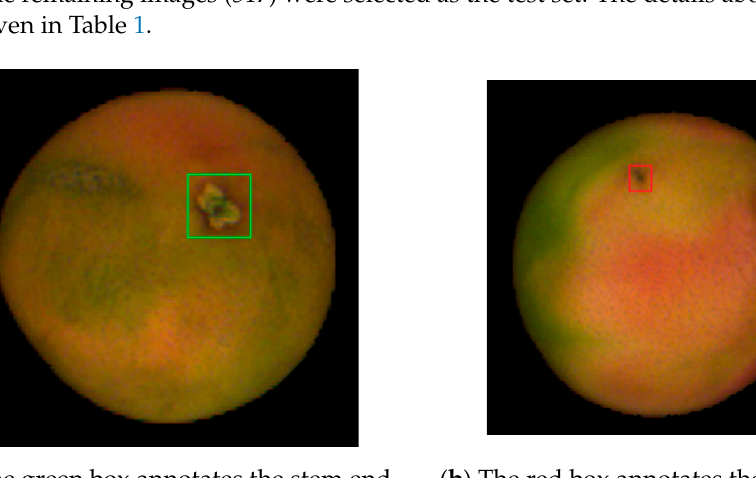
Figure 3. The eleven images captured while the pomelo rotating.